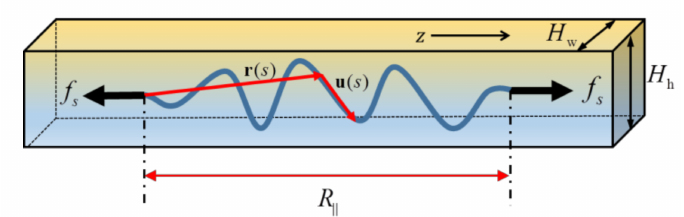
Figure 1. Schematic of a wormlike chain (WLC) confined in a rectangular tube and stretched by a